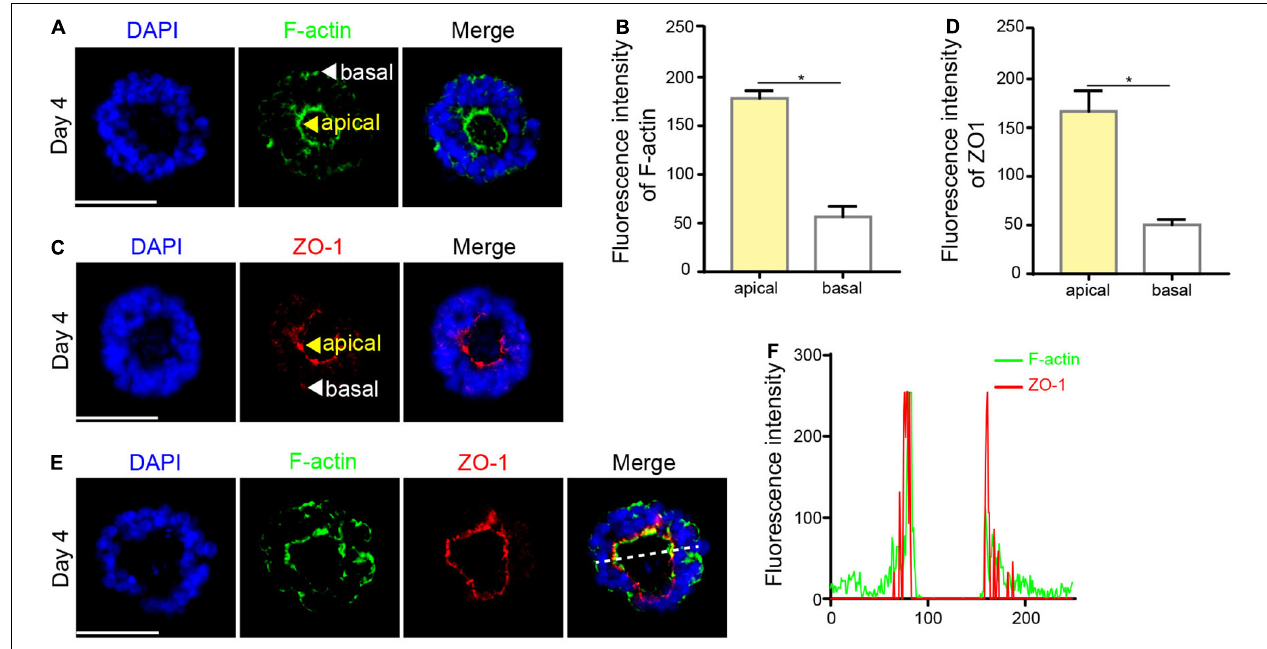
FIGURE 3 | The formation of a single lumen. (A,B) F-actin was concentrated at the apical area in the neural rosette. (C,D) ZO-1 was concentrated at the apical area in the neural rosette. (E) F-actin co-localized with ZO-1 at the apical area. (F) The fluorescence intensity of F-actin and ZO-1. Scale bars: 50 µ m. * P <